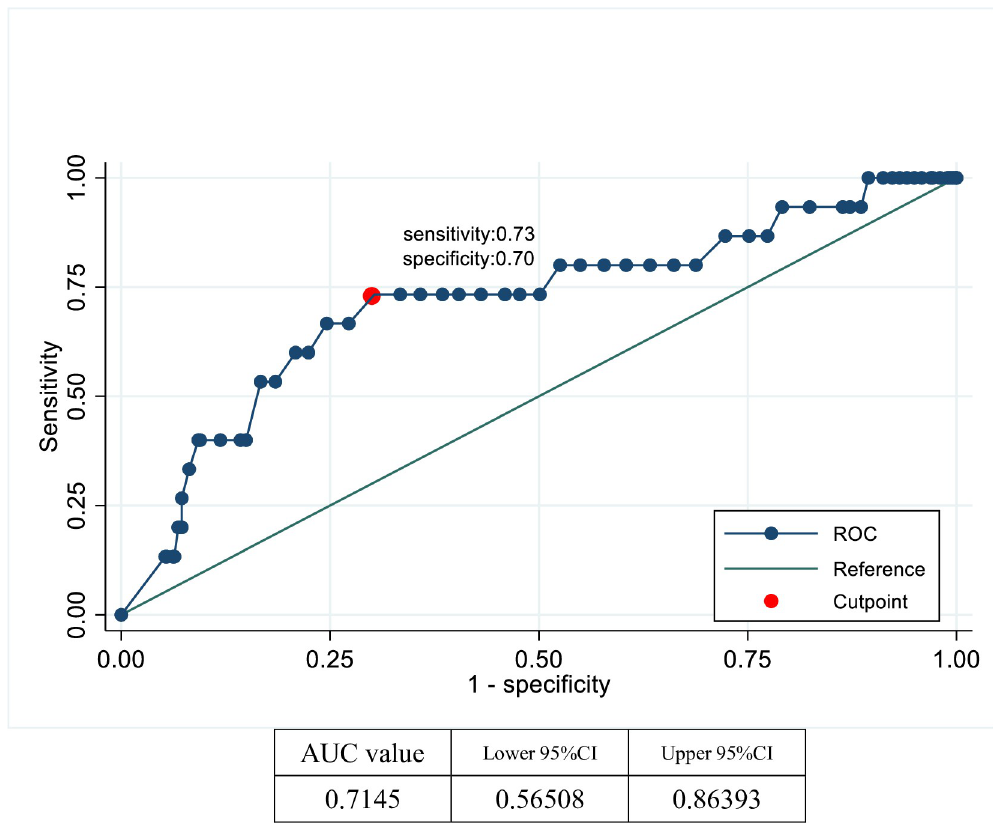
Fig 4. ROC curve analysis of resistance index in patients with rupture. (AVF